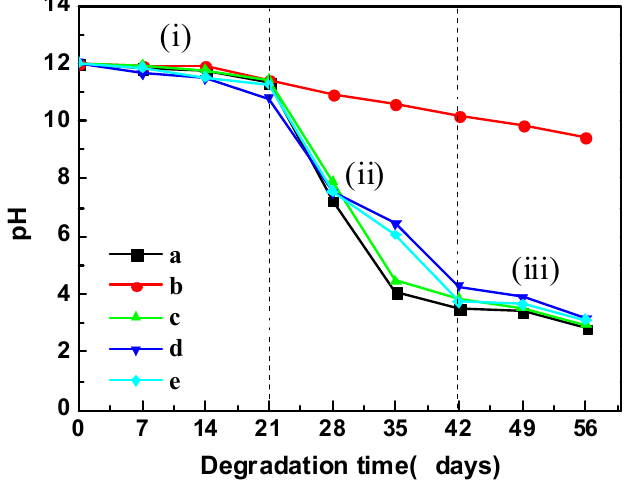
Figure 7. pH values of the hydrolytic mediums of ( a ) PLA; ( b ) PBAT; ( c )